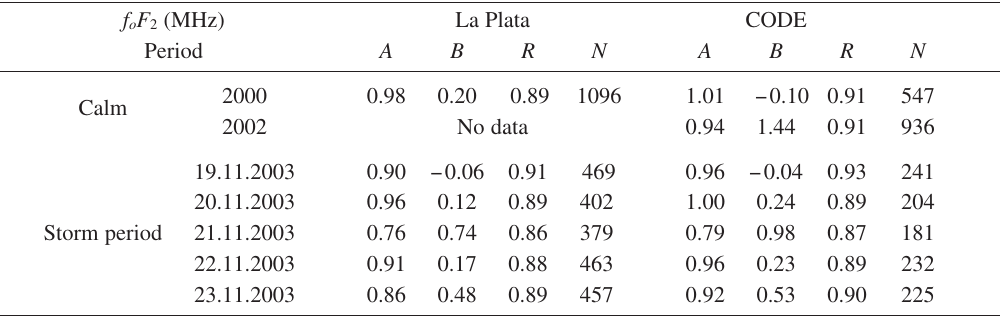
Table II. Linear regression fitting results for f o F 2 ( f o F 2 NeQuick = A ∗ f o F 2 Ionosonde + B ; R is the correlation co- efficient and N the number of selected data). f o F 2 (MHz) La Plata